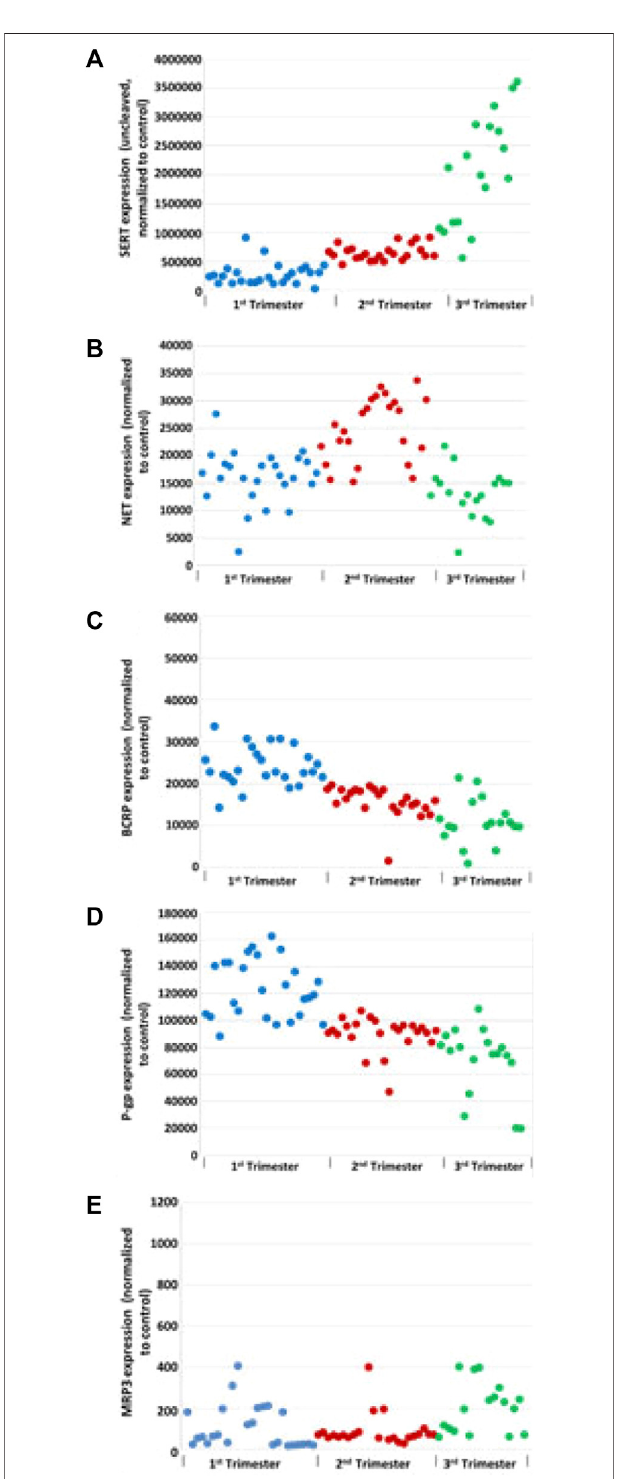
FIGURE 2 | Effect of GA on transporters levels: total SERT (A) , NET (B) , BCRP (C) ,P-gP (D) ,and MRP3 (E) inhumanplacentalmembrane vesiclesby Western blot analysis. Grb2 served as a loading